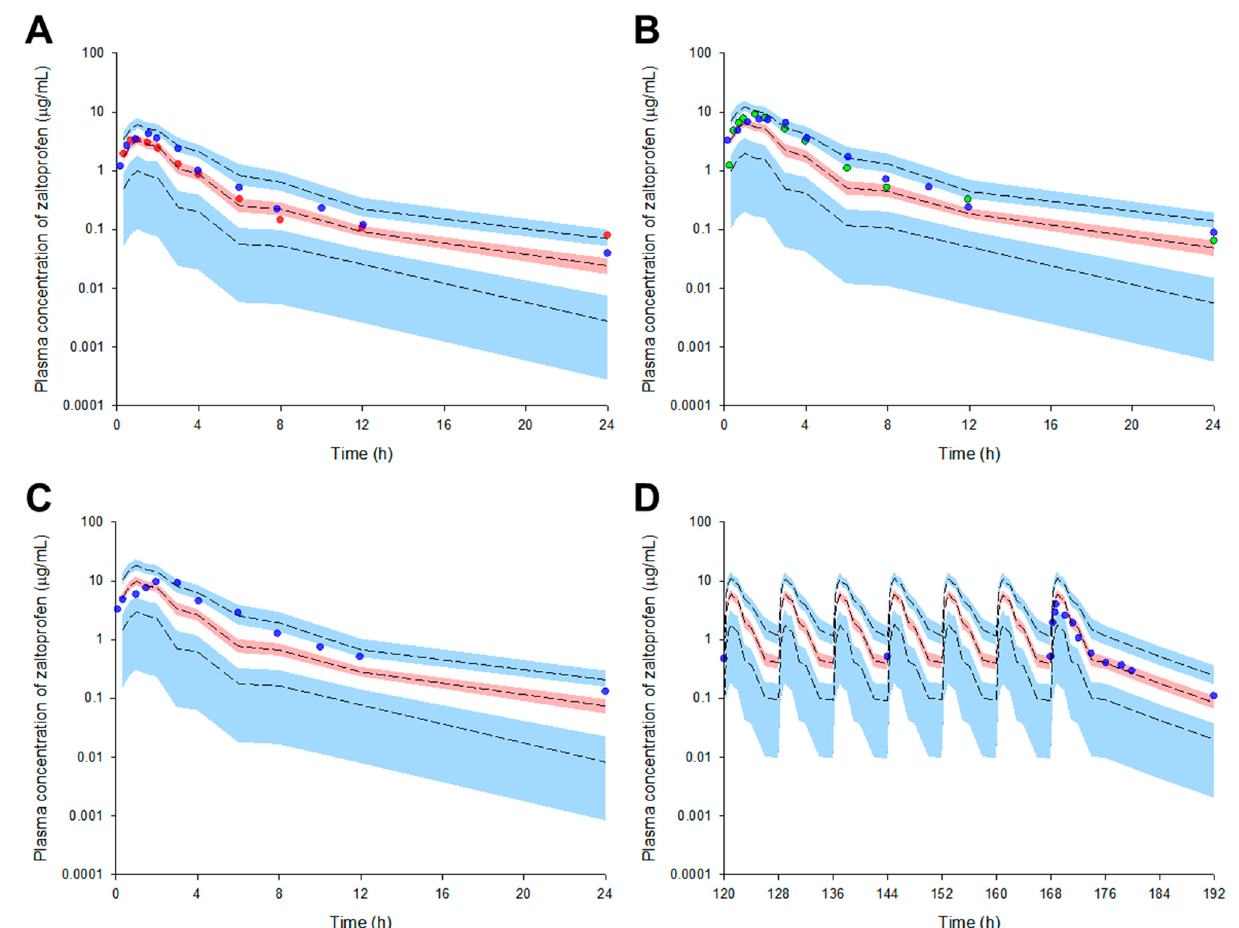
Figure 1. Simulation graphs of the pharmacokinetics of the final model for zaltoprofen according to single dose change (( A ) 80 mg, ( B ) 160 mg, and ( C ) 240 mg) or multiple doses (( D ) 80 mg). Observed concentrations after oral administration of 80–240 mg are depicted by the colored dots. The presented multiple exposure graph ( D ) is the simulation result for the observation area (120–192 h). The 95th, 50th, and 5th percentiles of the predicted concentrations are represented by black dashed lines. The 95% confidence intervals (CI) for the predicted 5th and 95th percentiles are represented by the blue-shaded regions. The 95% CI for the predicted 50th percentiles is represented by the red-shaded regions. The X-axis represents the time after oral zaltoprofen administration and the Y-axis is the observed and predicted zaltoprofen concentrations in the plasma. The red ( A ), blue ( A – D ), and green ( B ) dots represent mean data from Kang et al., (2006), Li et al., (2011), and Lee et al., (2006), respectively.